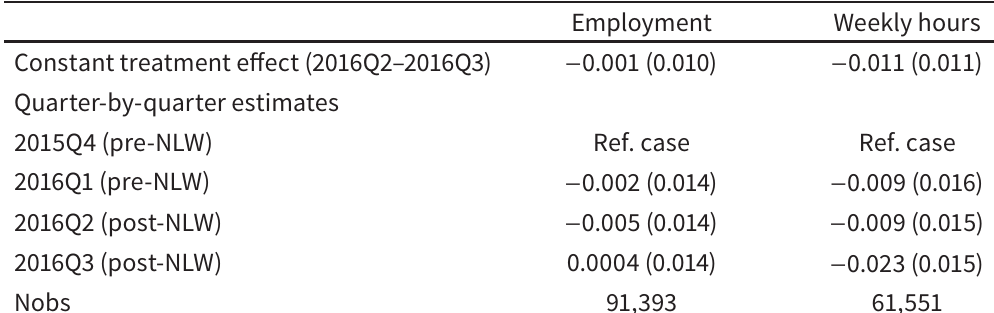
Difference-in-differences estimates of impacts of the NLW introduction on employment and hours in NI, coefficients (robust standard errors) Employment Weekly hours Constant treatment effect (2016Q2–2016Q3) Ref. case Ref.